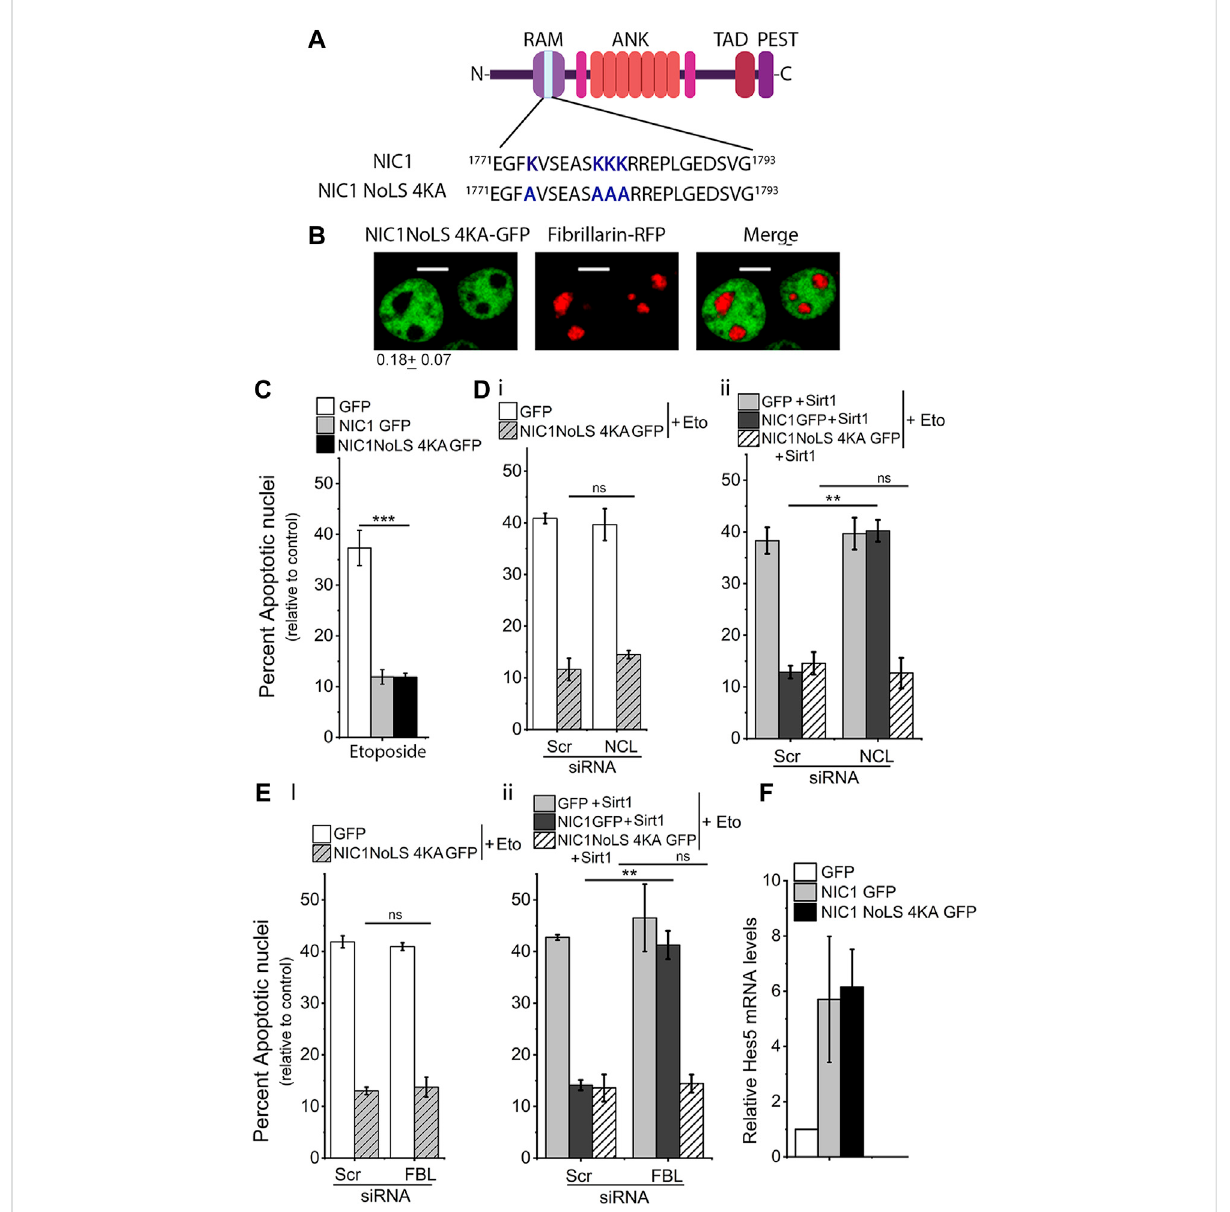
FIGURE 3 Lysine (K) to alanine (A) mutation in NIC1 abrogates dependence on FBL and NCL for protection against genomic damage. (A) Schematic showing lysine (K) to alanine (A) mutation in the putative NoLS in NIC1. (B) Representative confocal images of HEK cells co-transfected with NIC1- NoLS4KA-GFP and Fibrillarin-RFP and cultured for 24 h in complete medium post-transfection. Images are representative of 50 cells across two independent experiments. Scale bar: 5 μ m. 0.18 ± 0.07 shows the relative NIC1-NoLS 4KA levels in the nucleolus as compared to the nucleoplasm. (C) Percent apoptotic nuclei in HEK cells expressing NIC1-NoLS 4KA-GFP, NIC1-GFP, or GFP cultured with etoposide(10 µM)for 48 h in medium containing 2% FBS. (D,E) Percent apoptotic nuclei in HEK cells expressing NIC1-NoLS 4KA-GFP or GFP (Di,Ei) , NIC1 GFP + Sirt1, NIC1- NoLS4KA-GFP+Sirt1orGFP+Sirt1 (Dii,Eii) culturedwithetoposide(10 µM)inmediumcontaining2%FBSfor48 h.HEKcellspre-treatedwithsiRNA to NCL (D) , FBL (E) , or scrambled control for 48 h were transfected with indicated plasmids and cultured for 24 h before etoposide treatment. (F) Induction of Hes5 transcript levels in cells expressing NIC1-GFP or NIC1-NoLS 4KA-GFP relative to cells expressing the control GFP vector. Data plottedasmean±S.D.ofthreeindependentexperiments.***and**showsigni fi cantdifferencewith p -value ≤ 0.001and ≤ 0.01,respectively, andns shows non-signi fi cant difference examined using the unpaired student ’ s